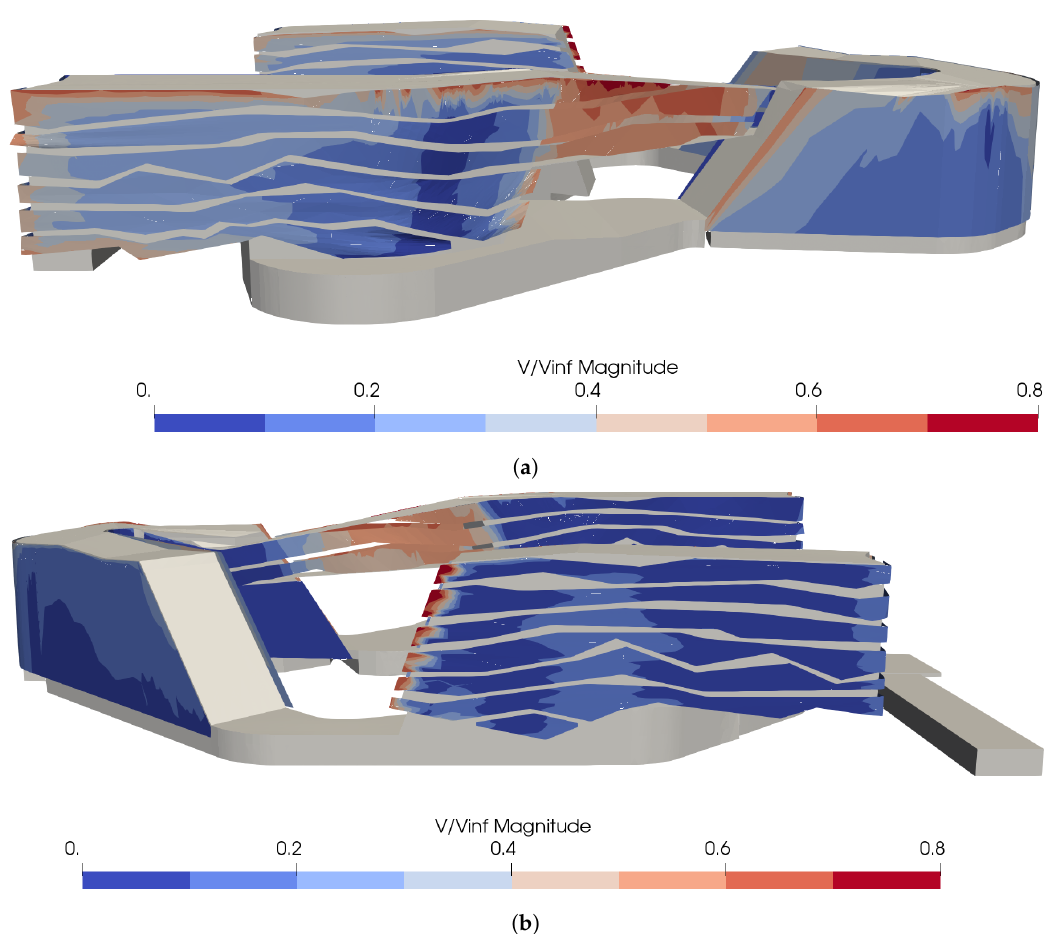
Figure 23. Mean crossing velocities measured in the midplane of the porous slabs, normalized in relation to the reference velocity. Wind direction − 30°. ( a ) Front view. ( b ) Rear